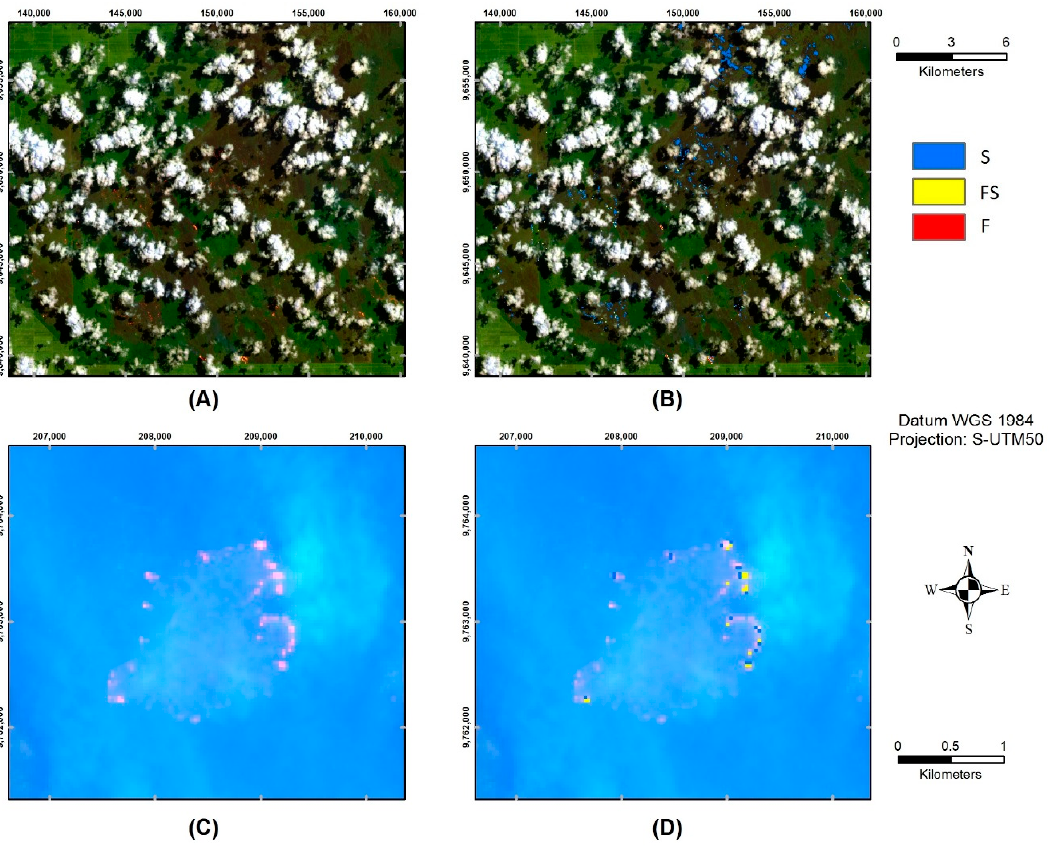
Figure 6. ( A , B ) An example of peatland combustion surrounded by cloud cover on a 764 RGB images of Landsat-8 on 4 September 2015 with the classified peatland combustion, ( C , D ) Peatland combustion in heavy smoke conditions and the classified peatland combustion on 20 September 2015.